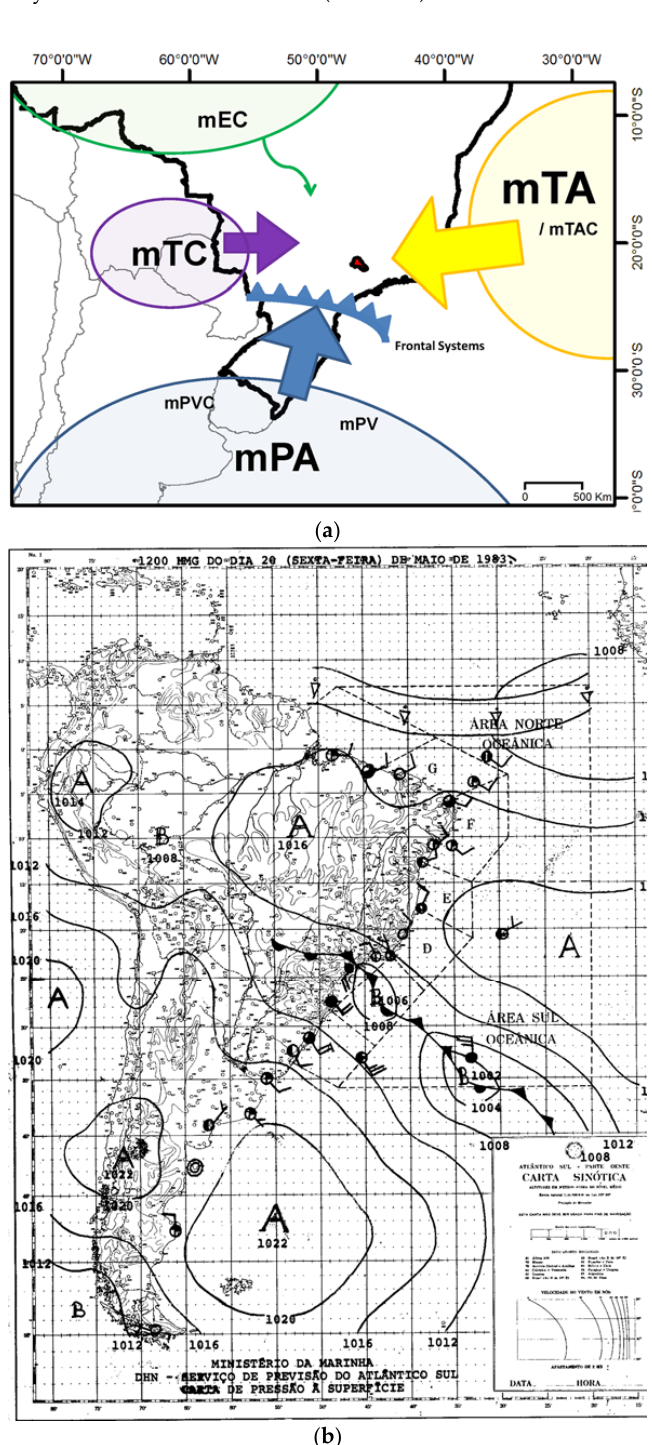
Figure 3. ( a ) Air masses by the source region and their main incursions into the Alto Pardo according to the data of [28,67] ( b ) Example of a synoptic chart provided by [57] (20 May 1983).